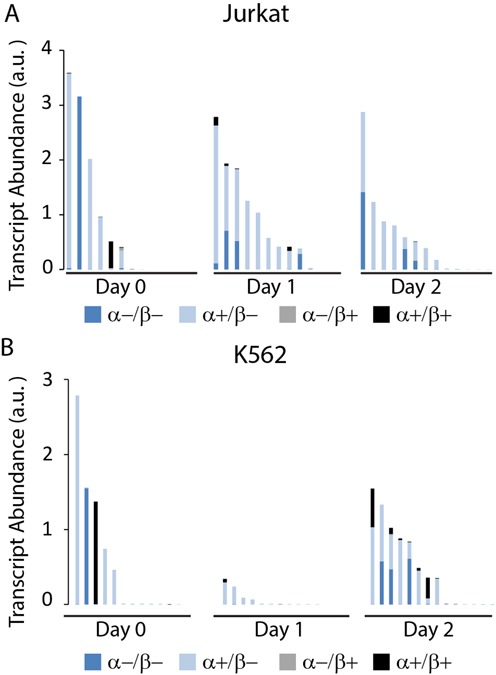
Single colony hTERT splice variant co-expression plots for (A) Jurkat and (B) K562 cells for days 0, 1 and 2. Each column represents results from one cell or colony. For each day, data are ordered by decreasing total hTERT transcript abundance levels. On day 0, when nearly all samples consist of single cells, hTERT consists of predominantly a single splice variant. Splice variants co-occur on other days presumably due to multiple cells present per sample, suggesting that a single cell expresses a single hTERT splice variant at any given time.